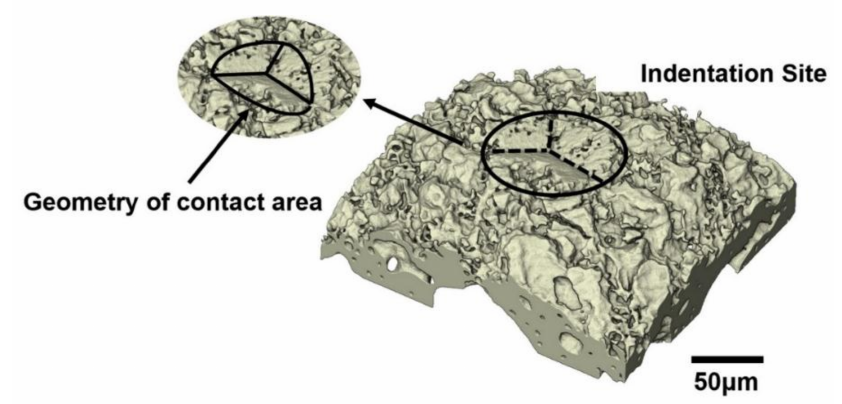
Figure 7. Volumetric rendering of the indentation site and geometry of the contact area after removal of the